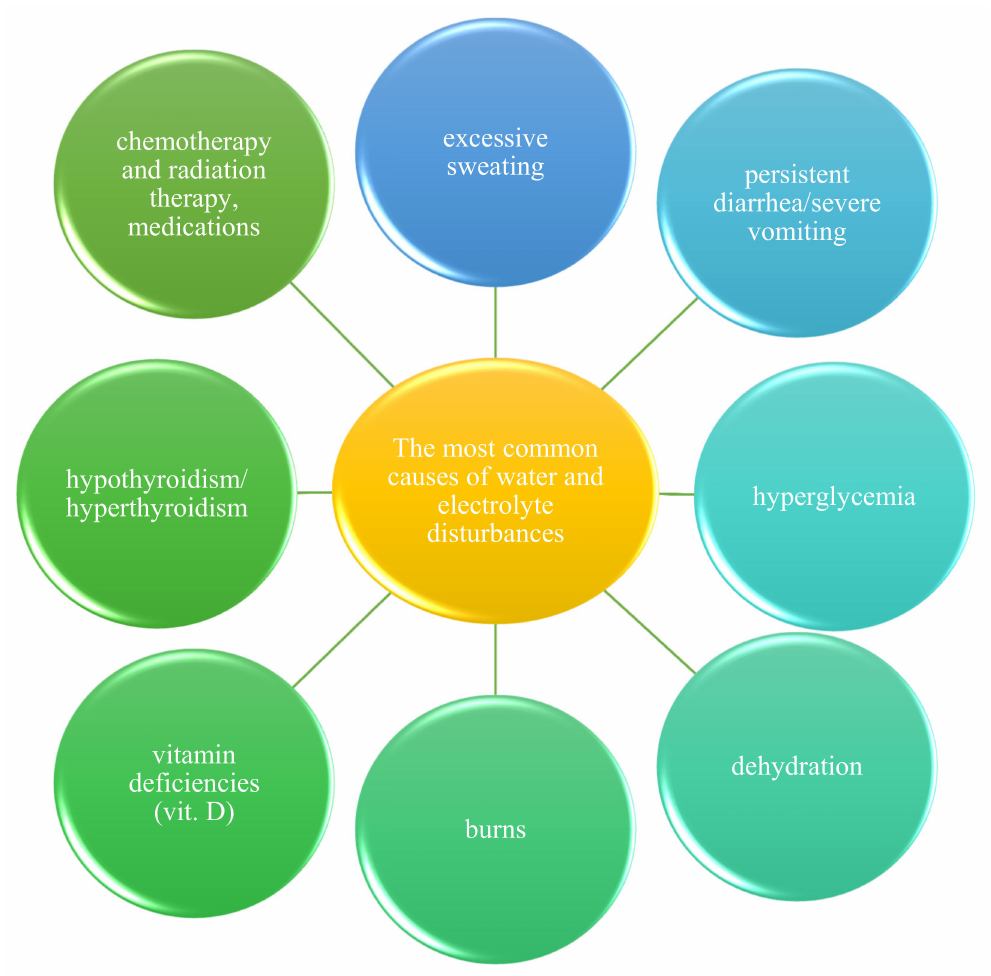
Figure 1. The most common causes of electrolyte and water disturbances; source: